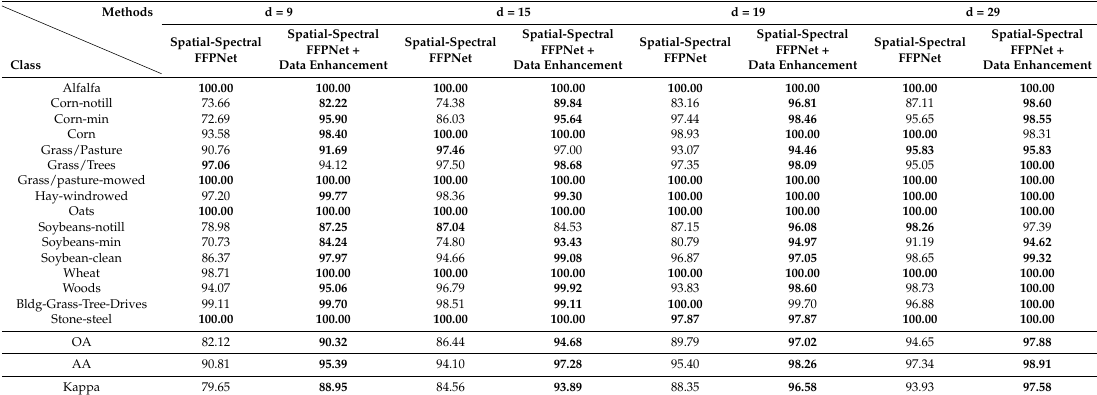
Table 14. Ablation study of data enhancement to spatial-spectral FFPNet performance (with sample patch sizes of d = 9, 15, 21, and 27 and 50 samples per category on the UP dataset; the values in bold are the best. All results are the average of three runs with maximum epoch = 200 and mini-batch size = 24.